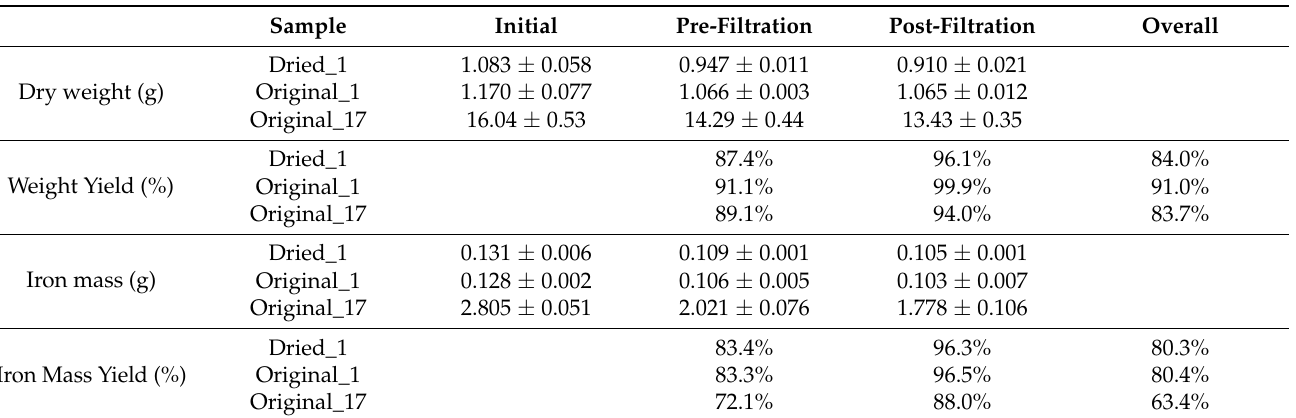
Table 2. Mass balance regarding total mass (dry weight) and iron content in the complexation process. Average ± standard deviation ( n = 2). Yield percentages refer to the stepwise (pre-filtration and post-filtration) and overall process yield of each sample, relative either to dry mass or iron mass in